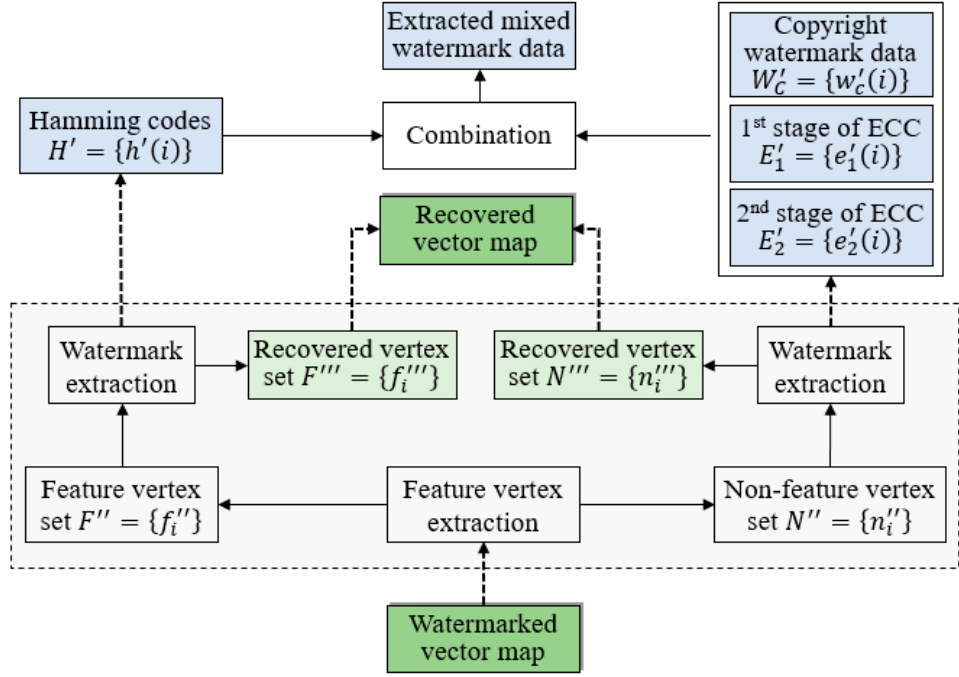
Figure 7. Diagram of watermark extraction and map content recovery.